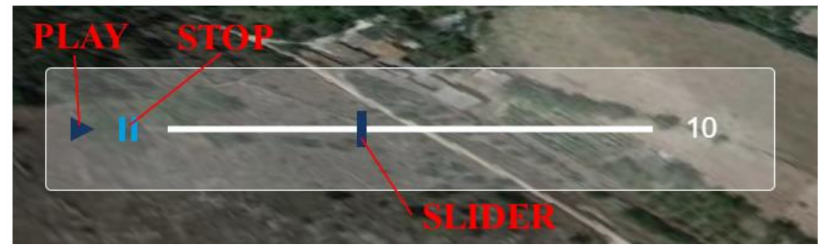
Figure 29. Toolbar animation.